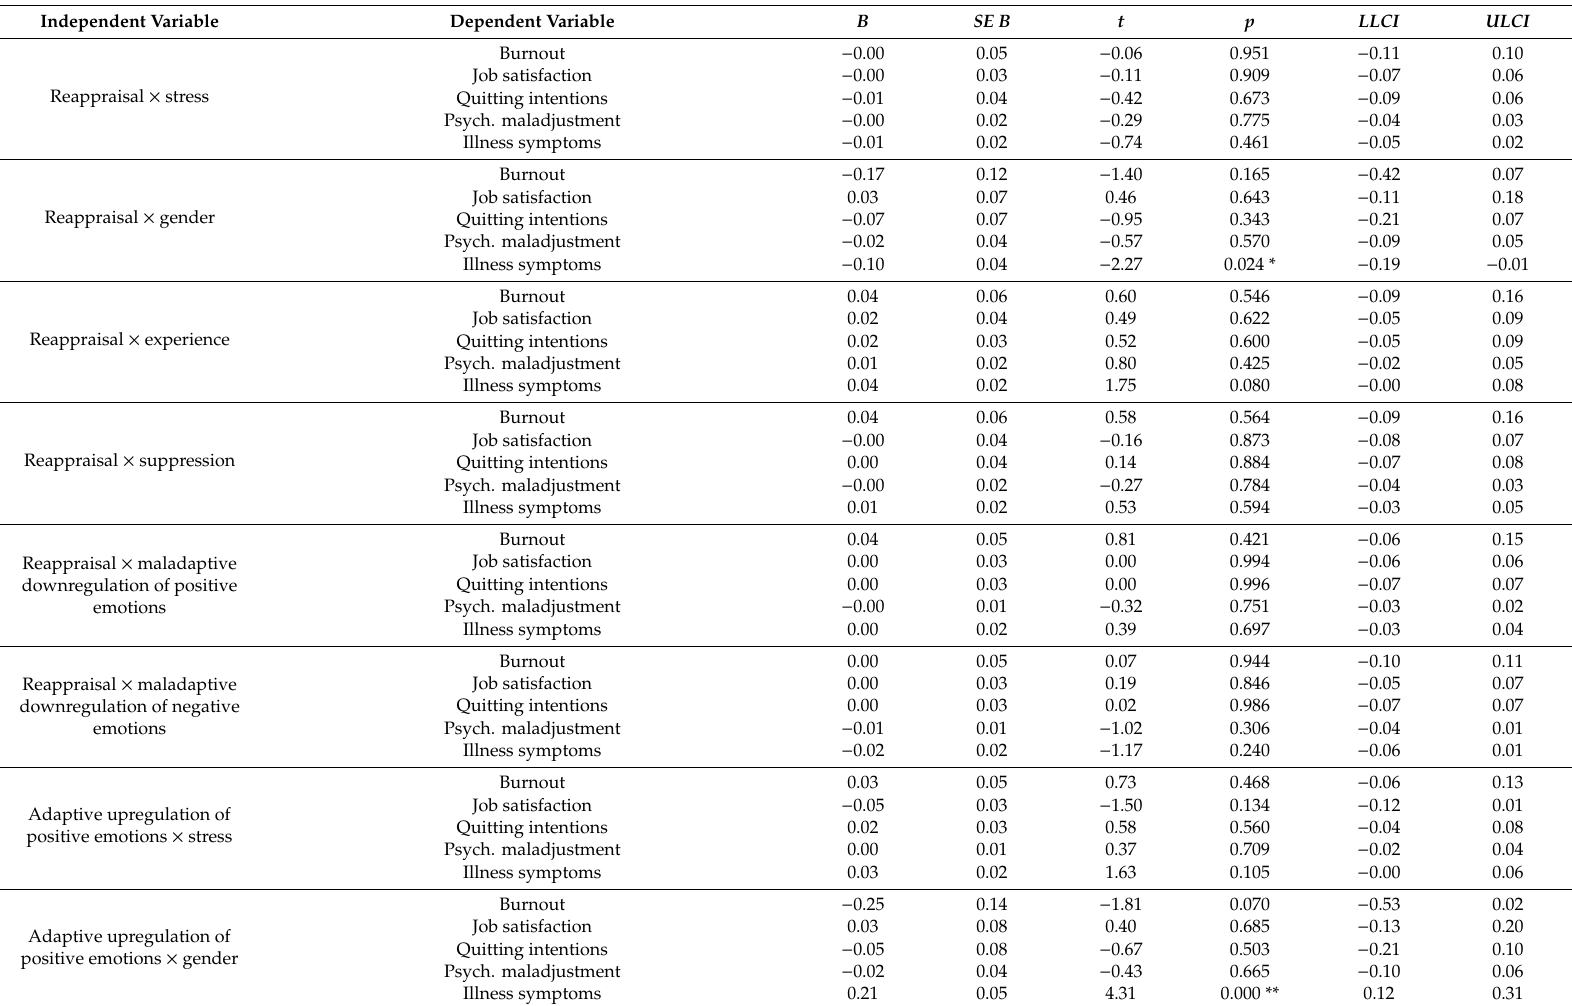
Table 6. Moderation Analyses for adaptive Emotion Regulation